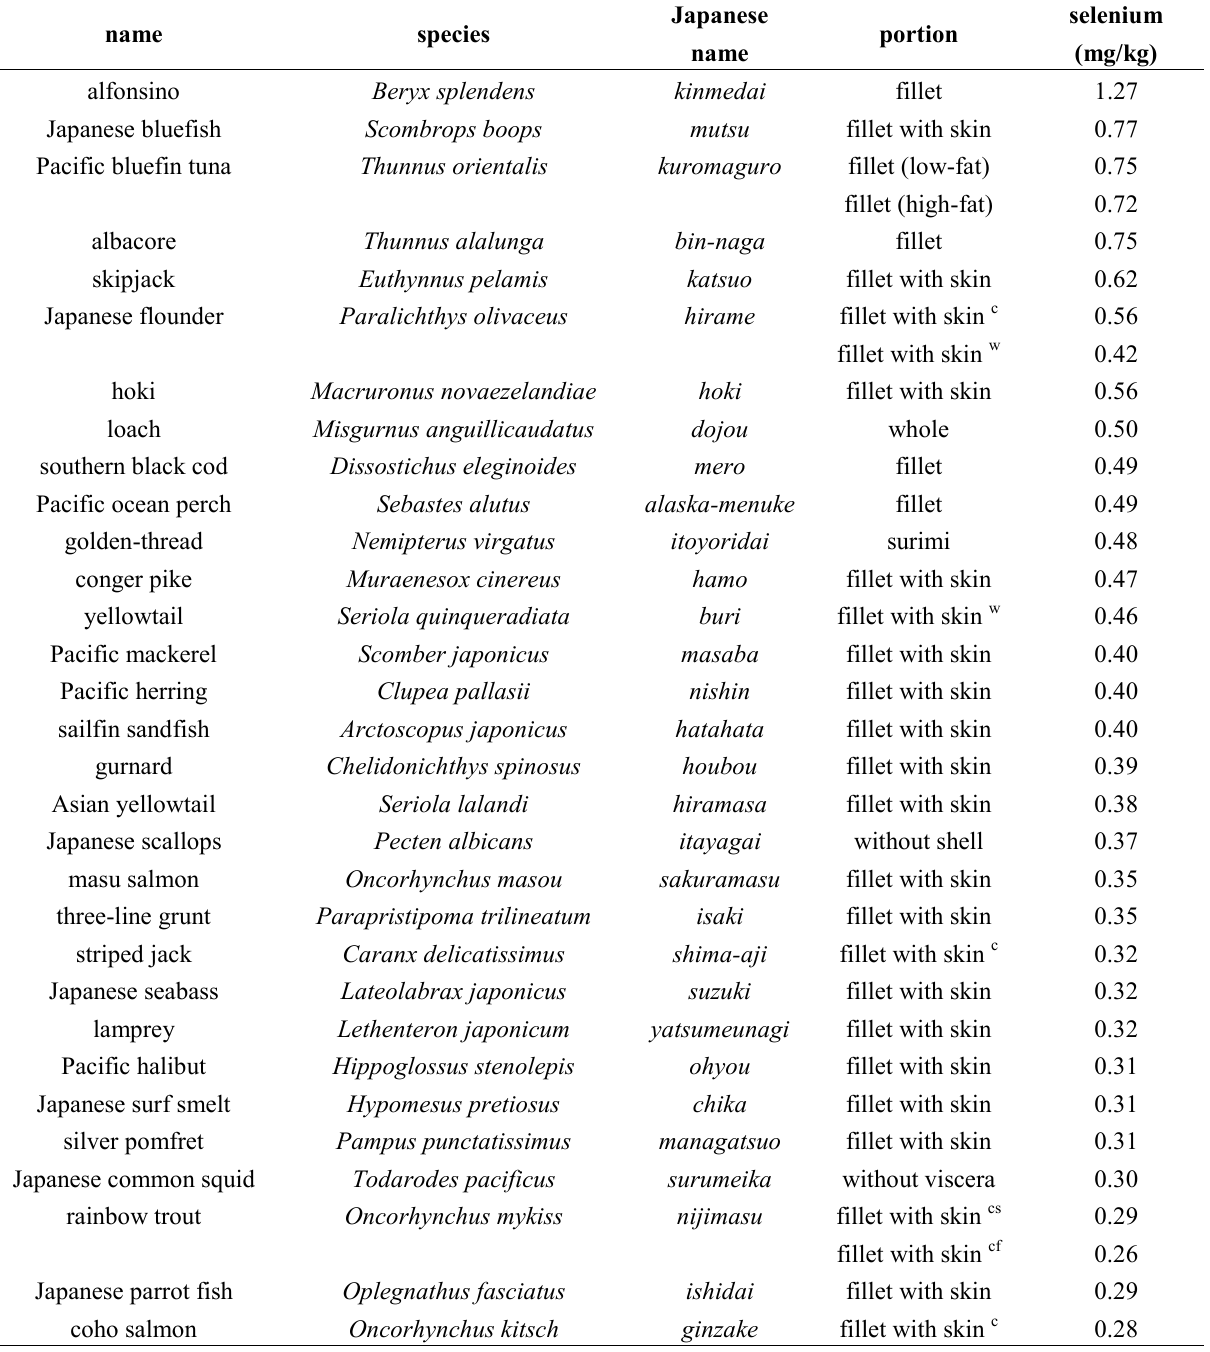
Table 1. Selenium content in the edible portions of fish and